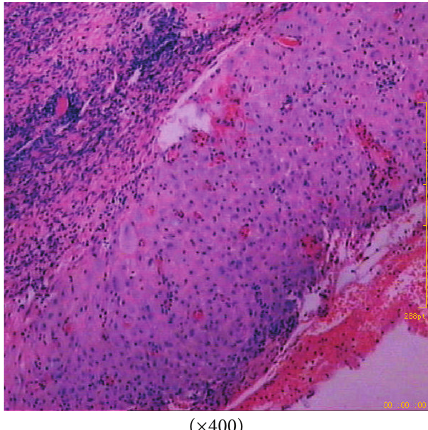
Figure 2: Histopathological view showing endometrial glands and stroma with extensive